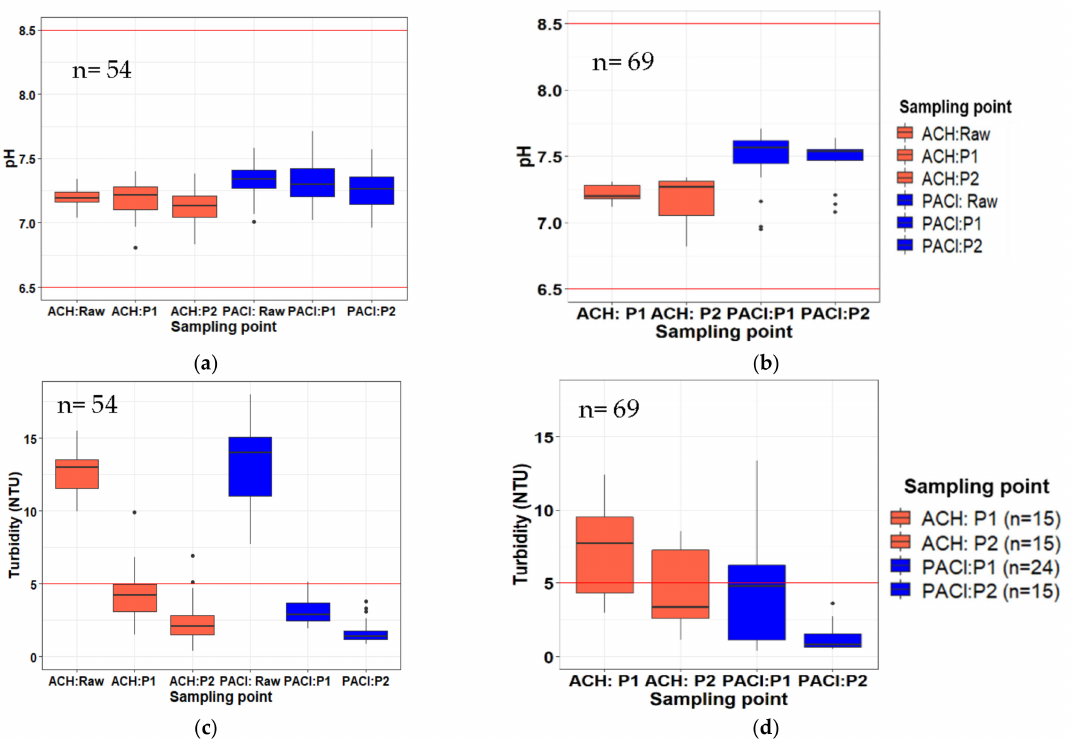
Figure 3. ( a ) pH in N-WTP, ( b ) pH in N-OKP, ( c ) turbidity in N-WTP, ( d ) turbidity in N-OKP. Note: P1 denotes Phase 1 and P2 denotes Phase 2. The red lines indicate the guideline values.